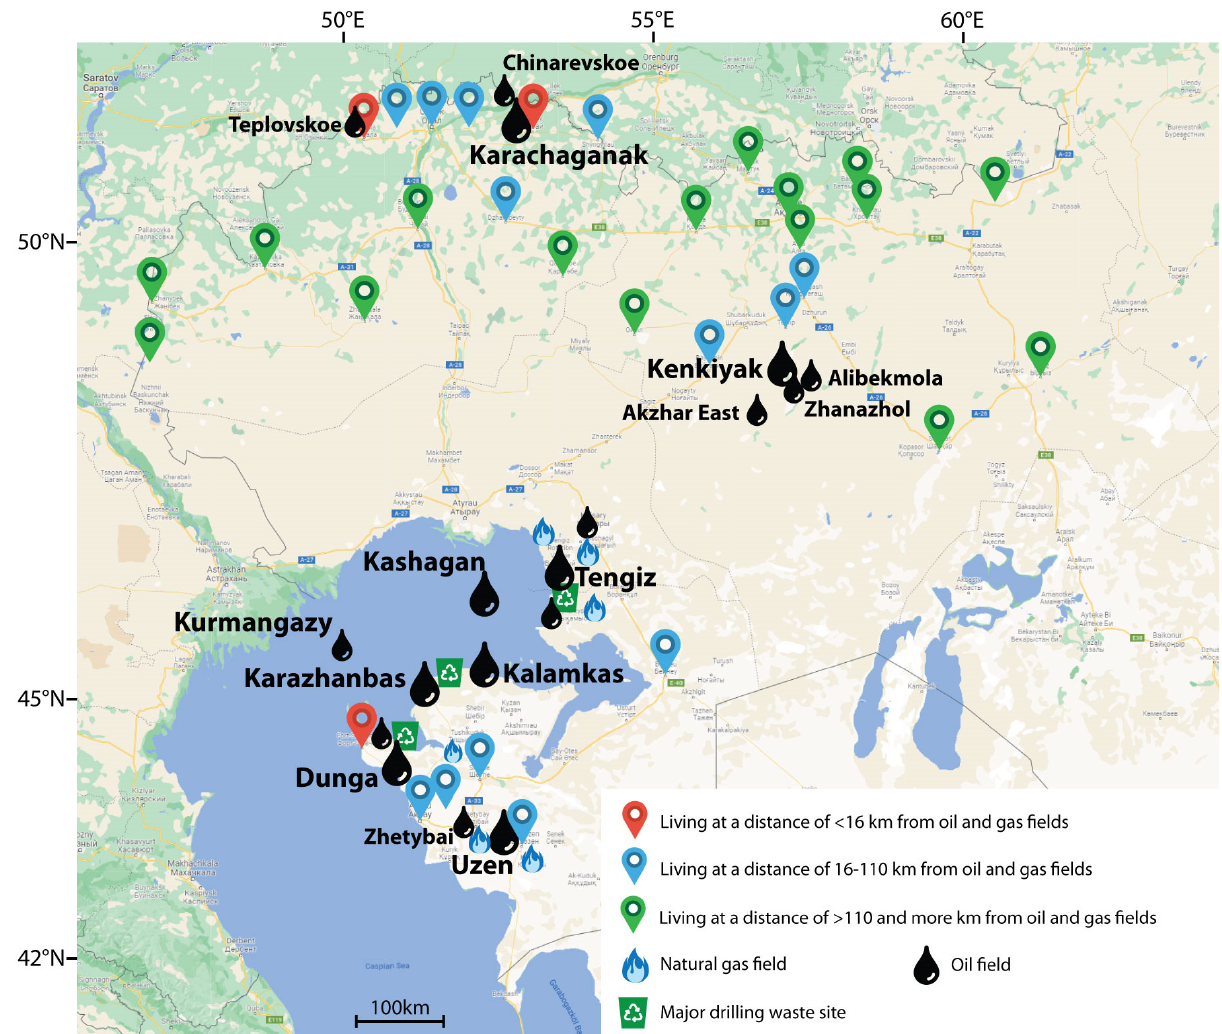
Figure 1. Map of the surveyed areas [36].